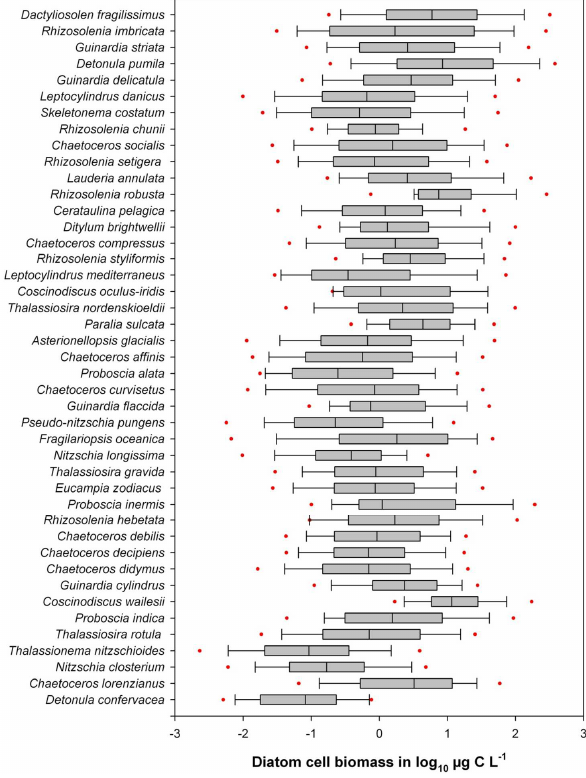
Figure 9. Boxplot of the main diatom species, contributing to 90% of the total biomass (log 10 µ gCl − 1 ) in the database. Red dots rep- resent the 5th and 95th percentiles. Species contribution to total biomass is arranged in decreasing order of abundance from top to bottom (see Table 3 for relative importance). All undetermined gen- era (example Chaetoceros spp.) were left out of the calculation to focus on identified species.